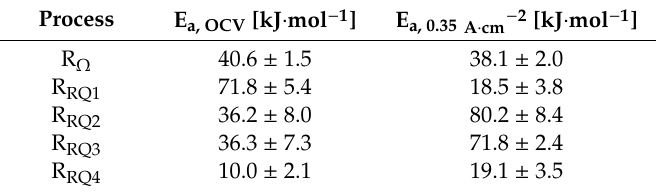
Table 1. Activation energies for the resistances R Ω and R RQ1 to R RQ4 for a ratio of CO 2 :CO of 80:20.